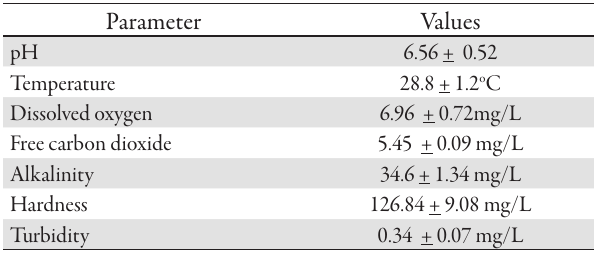
Tab. 1. Water quality parameters of dilution water used in